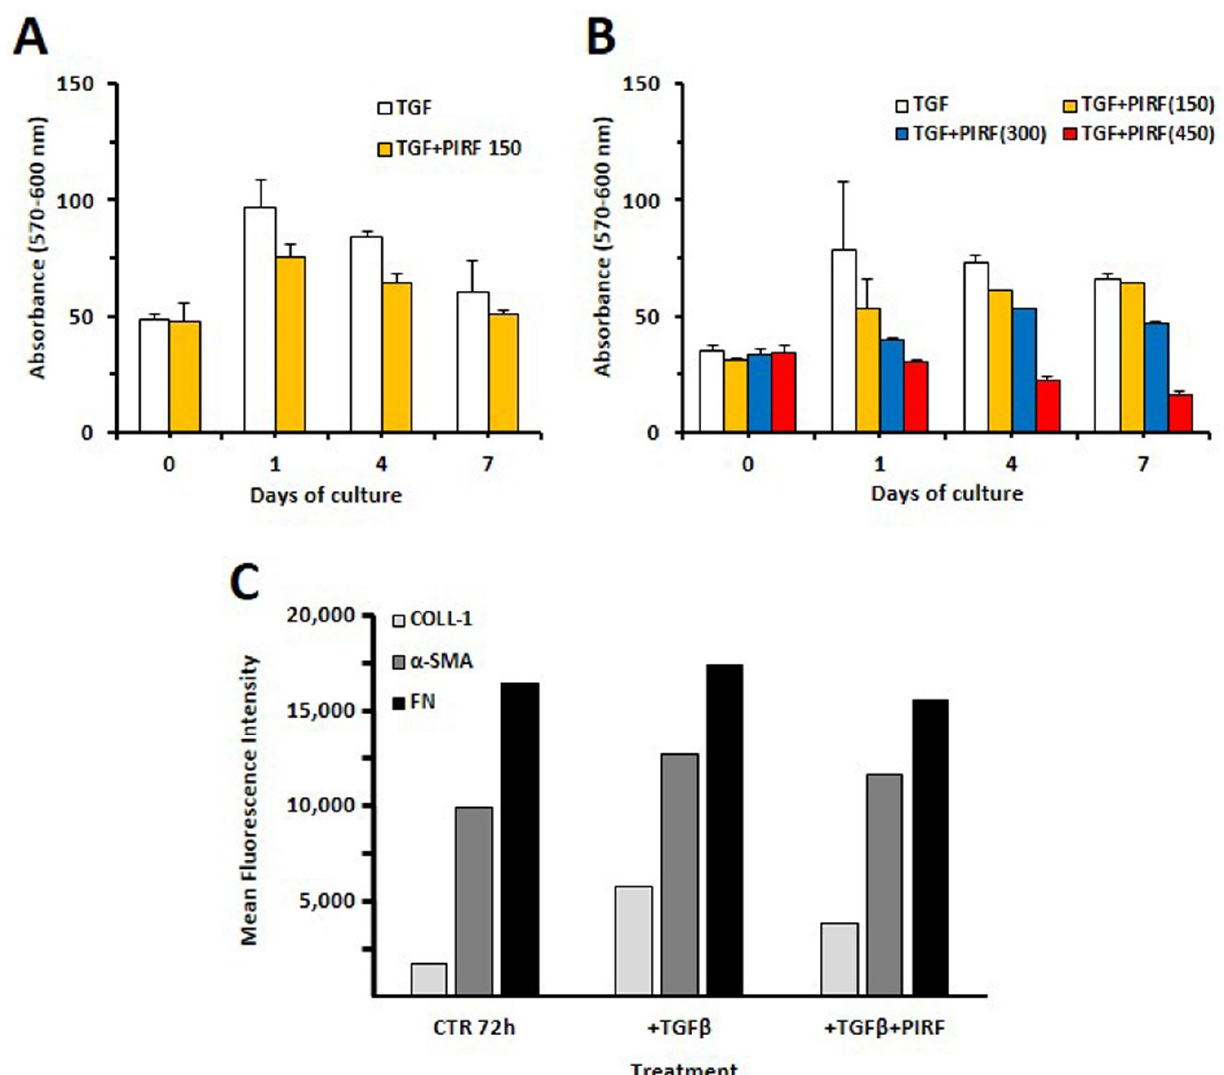
Figure 7. Evaluation of the TGF- β -induced proliferation or of the expression of typical myofibroblast markers in SCI13D in the presence/absence of pirfenidone treatment. ( A ) Pirfenidone (150 µ g/mL; PIRF) consistently reduced TGF- β -stimulated SCI13D proliferation as evaluated by Alamar Blue TM test at different timepoints; ( B ) inhibition of SCI13D cell proliferation resulted further strongly enhanced when pirfenidone was used at a higher concentration (i.e., 450 µ g/mL completely blocked cell growth). Histograms depict mean values of triplicate analysis; ( C ) pirfenidone strongly diminished TGF β -induced expression of type-1 collagen and, to a lesser extent, that of α - SMA or FN in SCI13D cells.